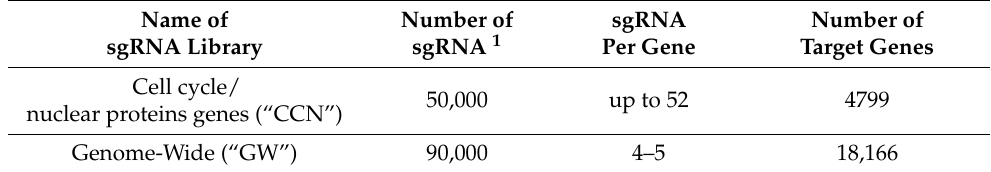
Table 1. Characteristics of the sgRNA libraries used for CRISPR/Cas9 screenings of MIA PaCa-2 pancreatic cancer